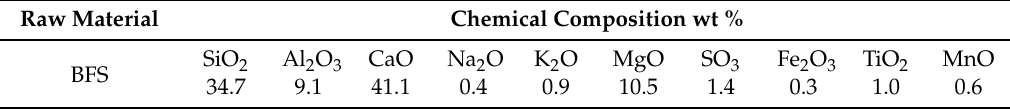
Table 1. Chemical composition of used BFS as determined by